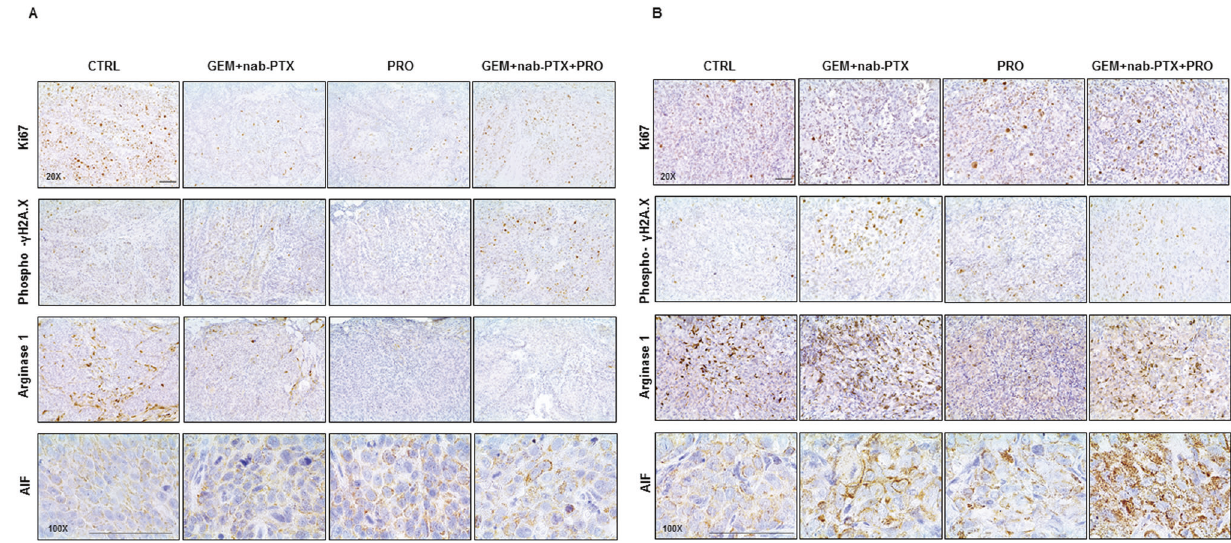
Fig. 2 Immunophenotypical characteristics of mice pancreatic cancer under chemotherapy and/or probiotic treatment. Representative immunohistochemical analyses of Ki67 (×20 magni fi cation), Phospho- γ H2A.X (×20 magni fi cation), Arginase 1 (×20 magni fi cation), and AIF (×10 magni fi cation) in BxPC-3 ( A ) and PANC-1 ( B ) tumor sections. Scale bar 50